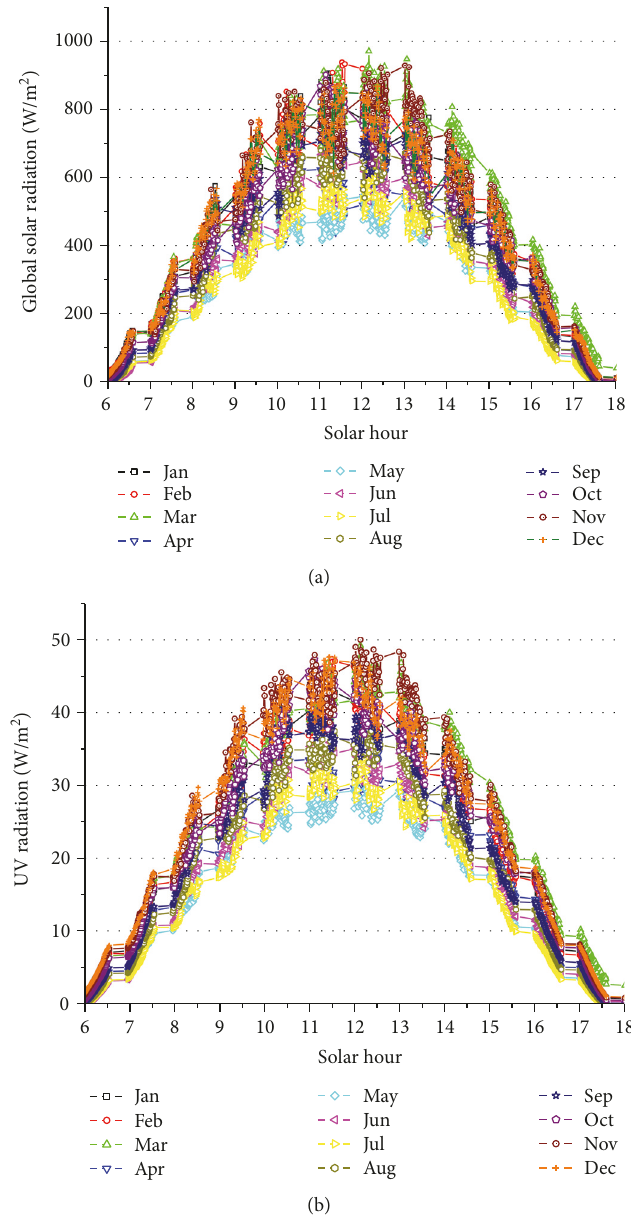
Figure 1: Global solar (a) and UV (A + B) radiation (b) monthly average in minute